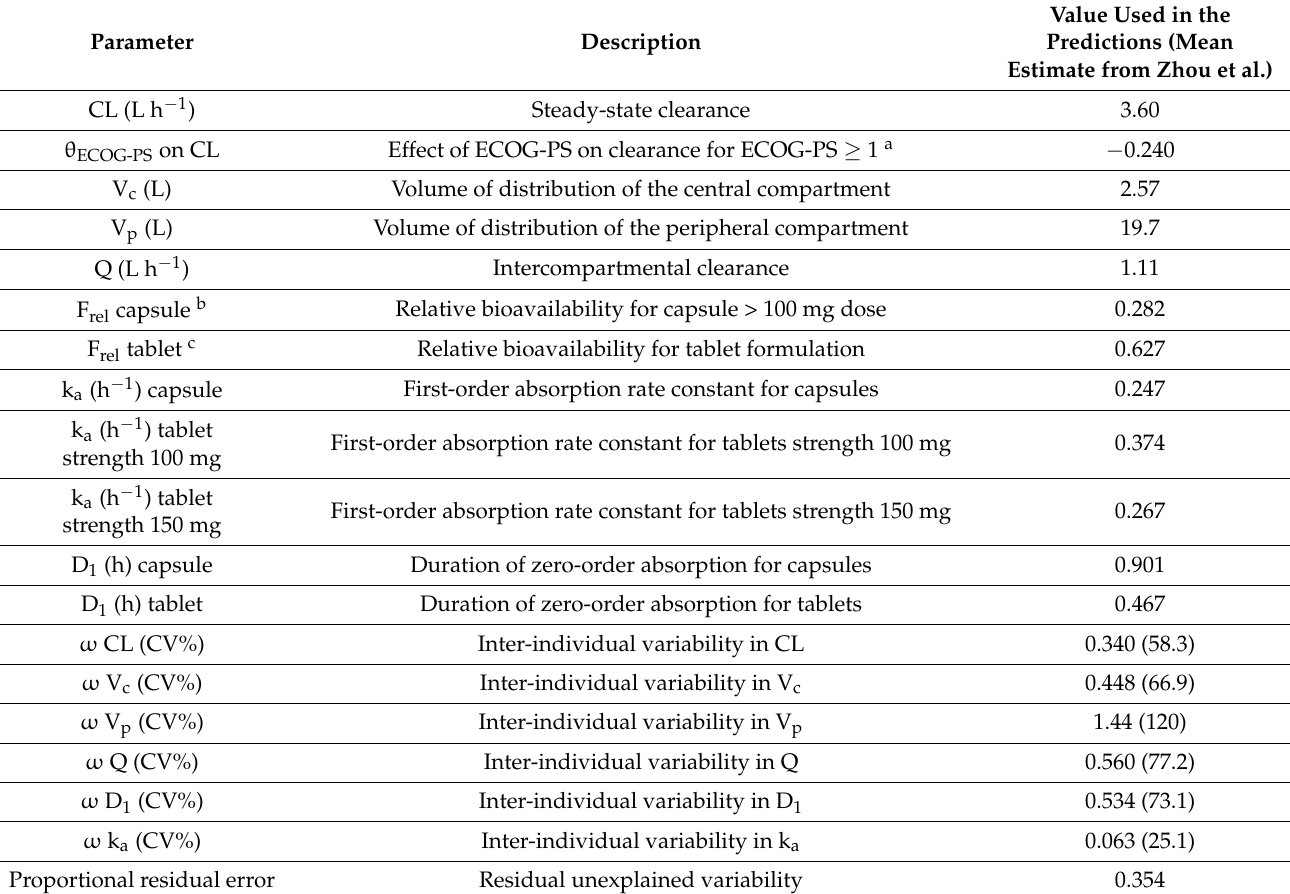
Table A1. Parameters used in the PK analysis obtained from Zhou et al.